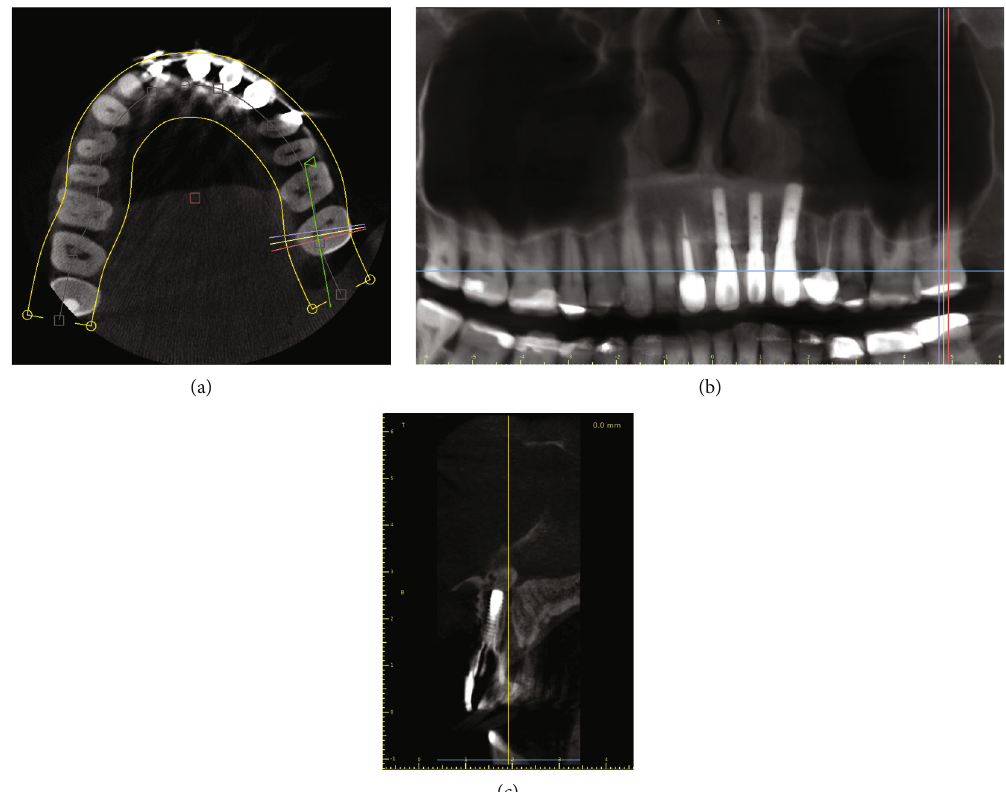
Figure 5: (a) Image showing sagittal section after 5 years. (b) Panoramic view showing the implant after 5 years. (c) Cone-beam computed tomography after 5-year